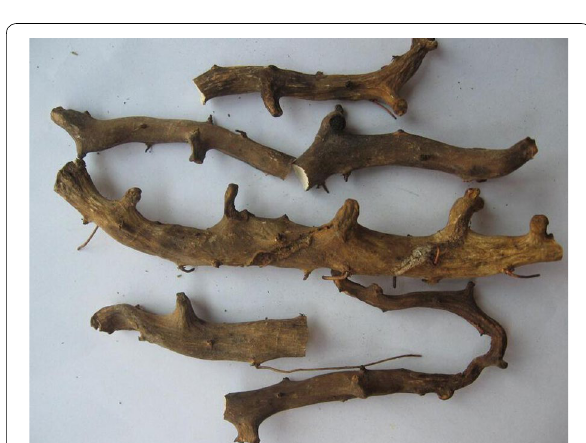
Fig. 2 Photos of the rhizomes of D.